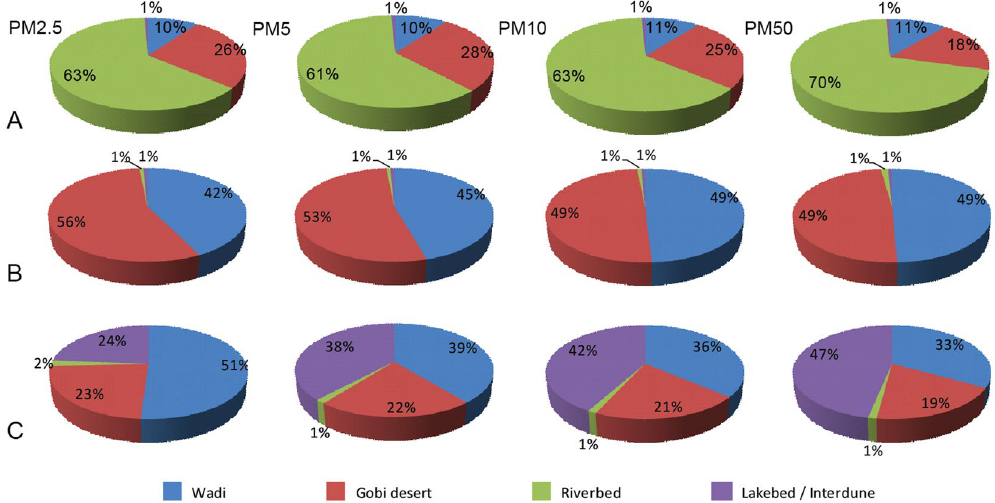
Figure 3. The comparison in the availabilities of PM2.5, PM5, PM10 and PM50 among different landscapes. ( A ) Qaidam Basin; ( B ) Ala Shan Plateau; and ( C ) Tarim Basin.